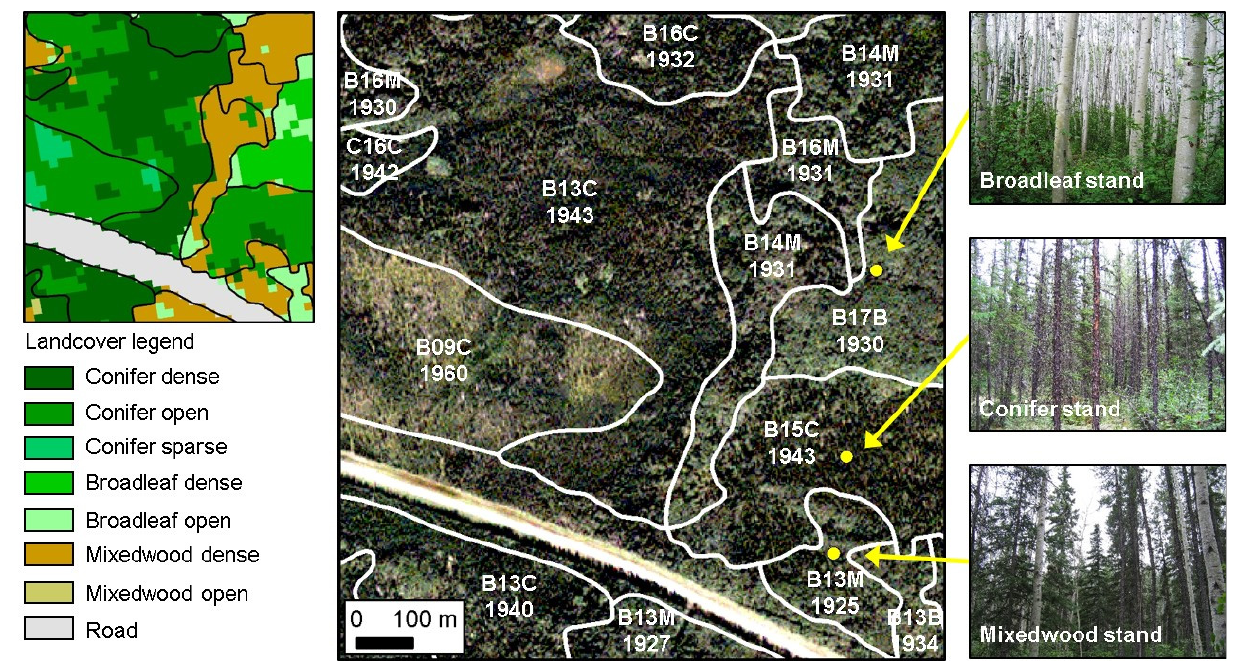
Figure 5. Sample Multisource Vegetation Inventory (MVIv) map for a 1.0 by 1.16 km area some 50 km south of Fort Simpson. The left inset shows the area with the landcover map as a backdrop. The backdrop of the central inset is a Quickbird image of the same area taken in August 2006. The first letter in a polygon’s label is the density class (Table 1), the next 2 digits are the mean stand height, the last letter is the broad forest type (conifer, broadleaf, or mixedwood), and the 4 digits below are the origin year. The photos to the right show 3 ground plots (yellow dots in the central inset) of different forest types.